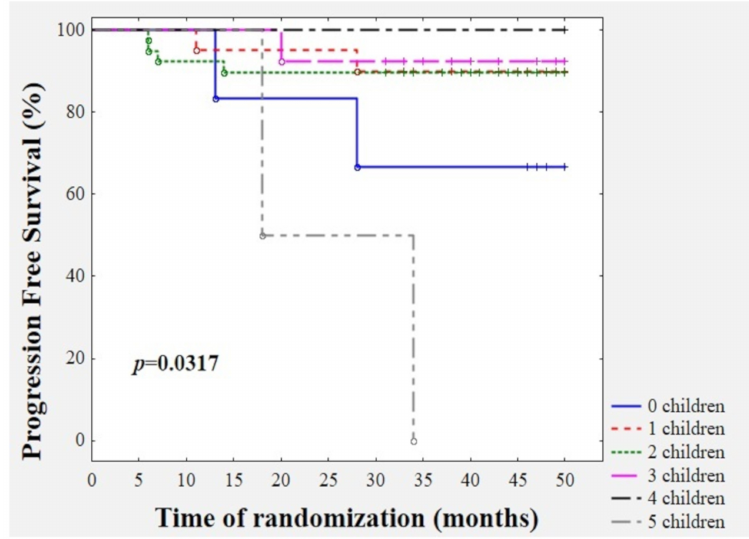
Figure 5. Kaplan–Meier survival analysis according to parity